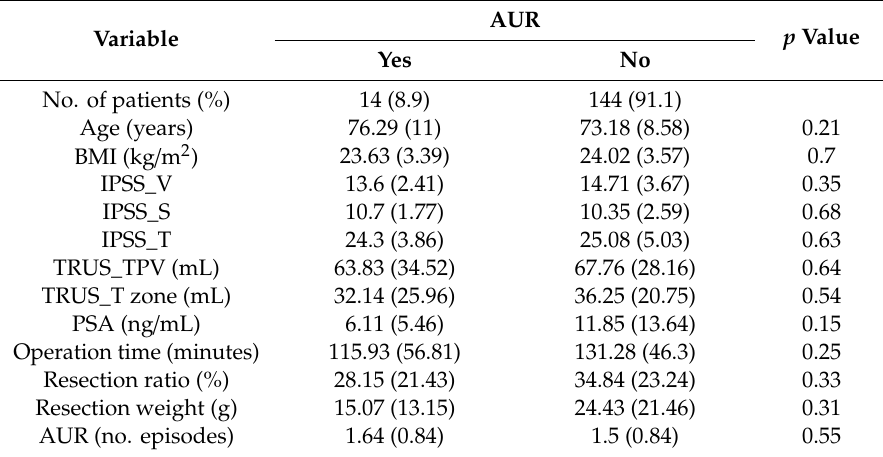
Table 2. AUR within 3 months after